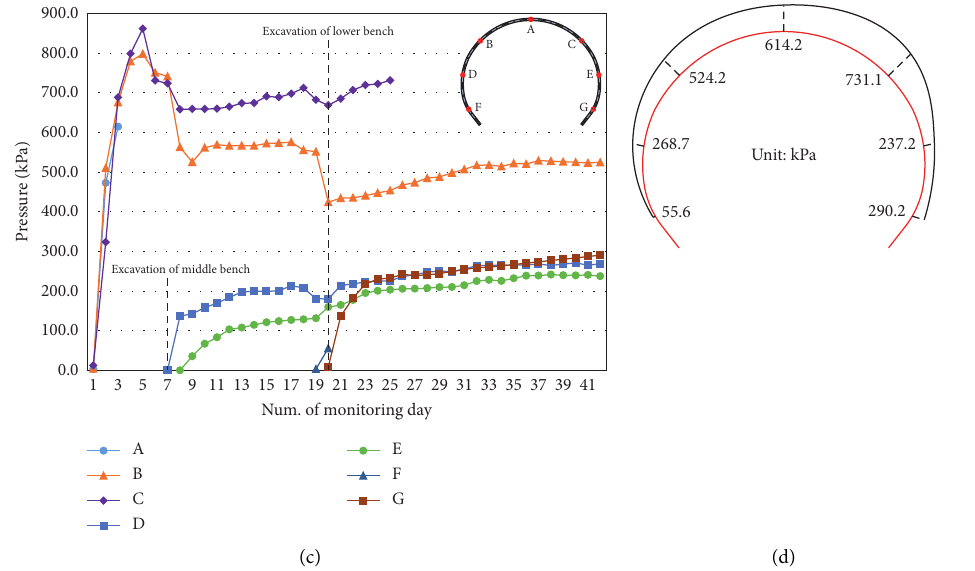
Figure 12: Surrounding rock pressure on the primary lining: (a) time-history curve and (b) spatial distribution at Z5K64+500; (c) time- history curve and (d) spatial distribution at Z5K64+540. The spatial distribution diagrams were based on the last data of the time-history curve.